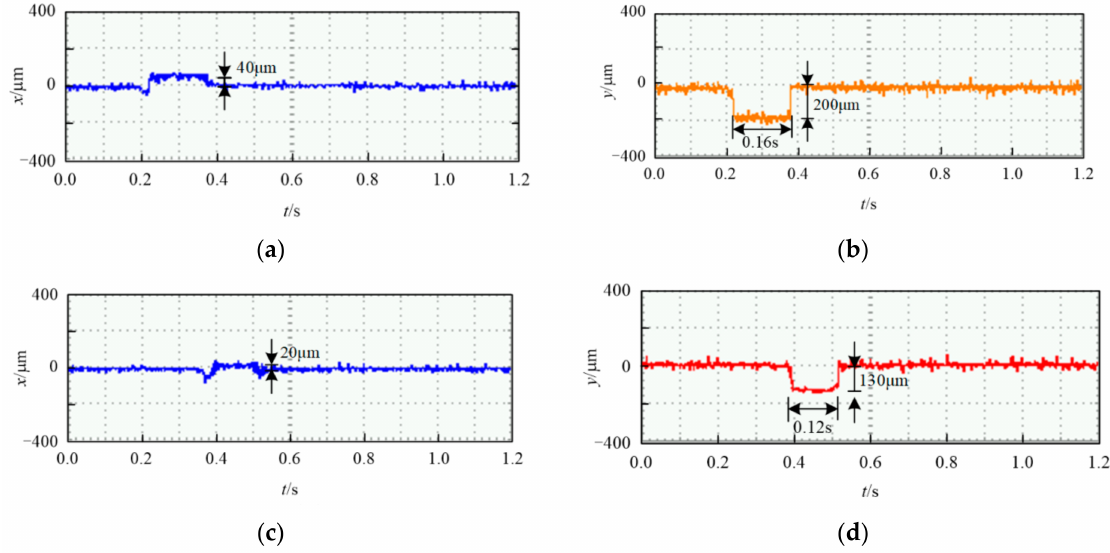
Figure 11. Displacement waveforms of anti-interference experiment based on the PSO and MPSO. ( a ) displacement waveform in the x direction of PSO. ( b ) displacement waveform in the y direction of PSO when disturbed. ( c ) displacement waveform in the x direction of MPSO. ( d ) displacement waveform in the y direction of MPSO when